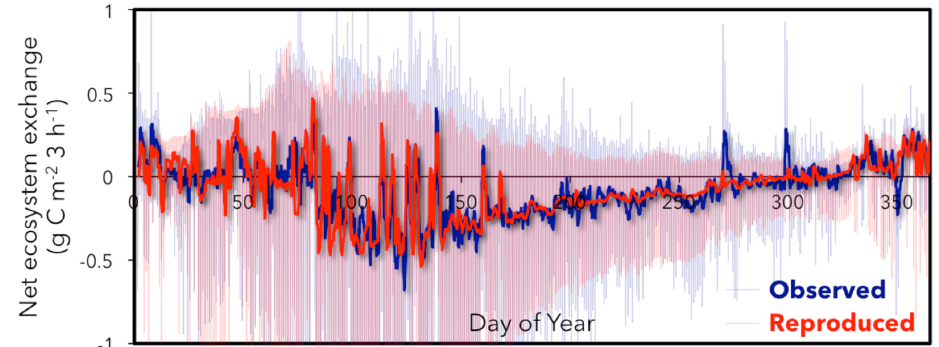
Figure 3. The observed net ecosystem exchange (NEE) (blue) and reproduced NEE (red) shown at the 3-hourly time step with daily moving window overlaid for a single year from the Tonzi Ranch AmeriFlux/FLUXNET site (Baldocchi and Ma, 2013).